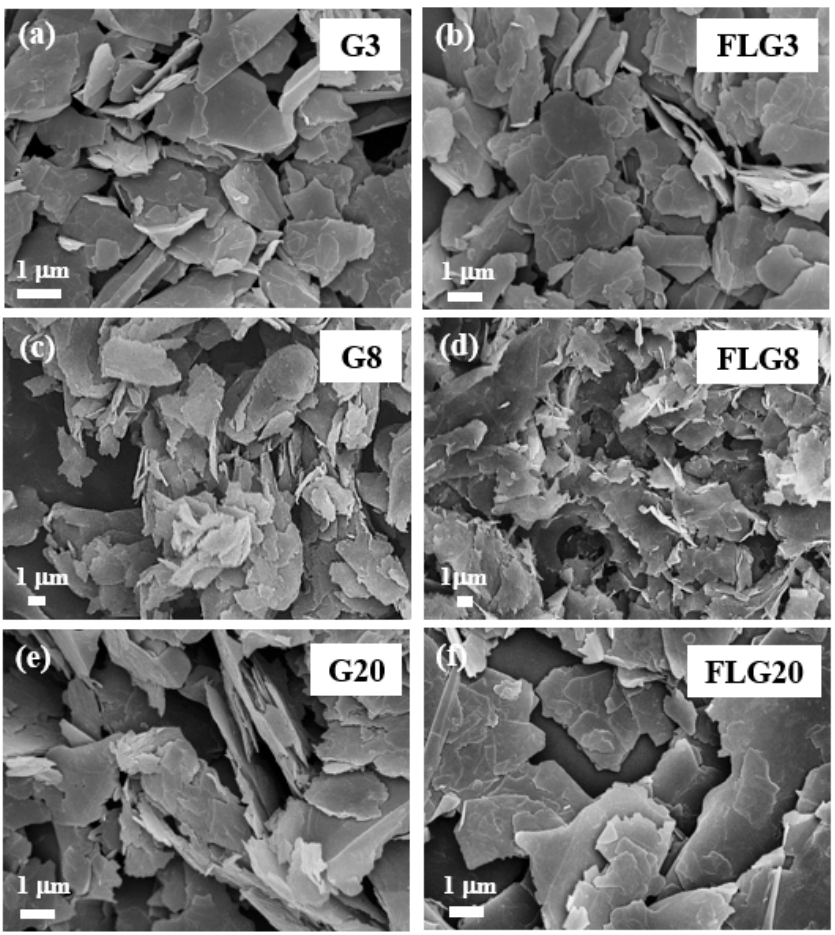
Figure 1. Scanning electron microscopy (SEM) images of ( a ) graphite (G)3, ( b ) few-layered graphene